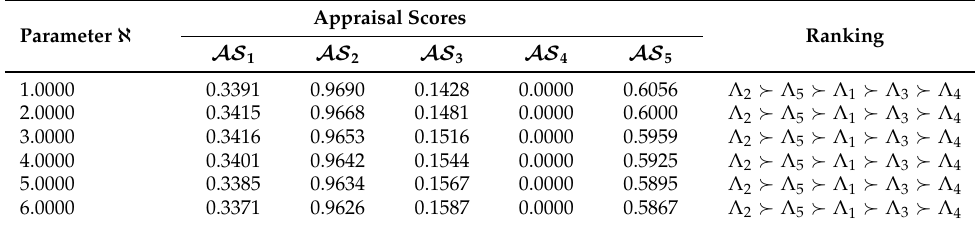
Table 9. Decision results regarding different parameter values for the distance measure. Appraisal Scores Parameter χ AS